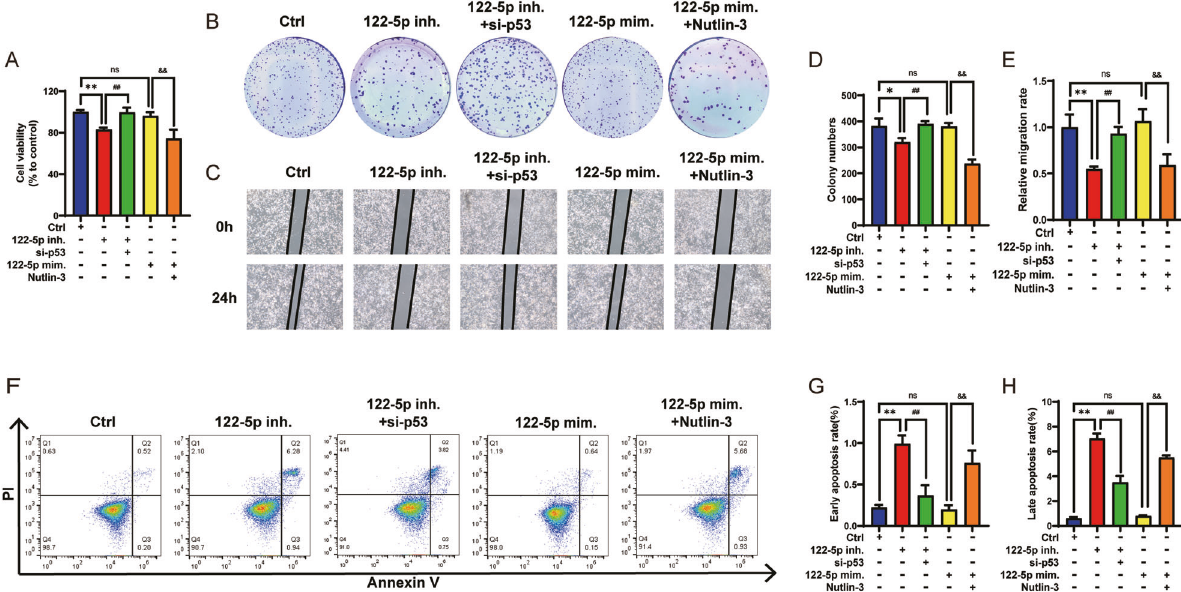
Fig. 1 Characterization of miR-122-5p mediated p53 effects in A549 cells. A The proliferation of A549 cells treated with 122-5p inh. combined with si-p53 or 122-5p inh. alone or 122-5p mim. combined with Nutlin-3 or 122-5p mim. alone using the CCK-8 assay. The colony formation assay could detect the long-term proliferation ability of A549 cells treated with 122-5p inh. combined with si-p53 or 122-5p inh. alone or 122-5p mim. combined with Nutlin-3 or 122-5p mim. alone ( B ) and the bar graph corresponding to B ( D ). The migration ability of A549 cells treated with 122-5p inh. combined with si-p53 or 122-5p inh. alone or 122-5p mim. combined with Nutlin-3 or 122-5p mim. alone using the cell scratch assay ( C ) and the bar graph corresponding to C ( E ). The apoptosis of A549 cells treated with 122-5p inh. combined with si-p53 or 122-5p inh. alone or 122-5p mim. combined with Nutlin-3 or 122-5p mim. alone using fl ow cytometry ( F ) and the analysis of early apoptosis ( G ) and late apoptosis ( H ). The above bar graphs were the sum of three independent experiments (mean ± SD). The ctrl group was represented by A549 cells treated using a medium solution containing 122-5p inh. NC and 122-5p mim. NC and si-p53 NC and DMSO, ns: not signi fi cant, * P < 0.05 and ** P < 0.01 vs . Ctrl group, # P < 0.05 and ## P < 0.01 vs. 122-5p inh. group, & P < 0.05 and && P < 0.01 vs. 122-5p mim.